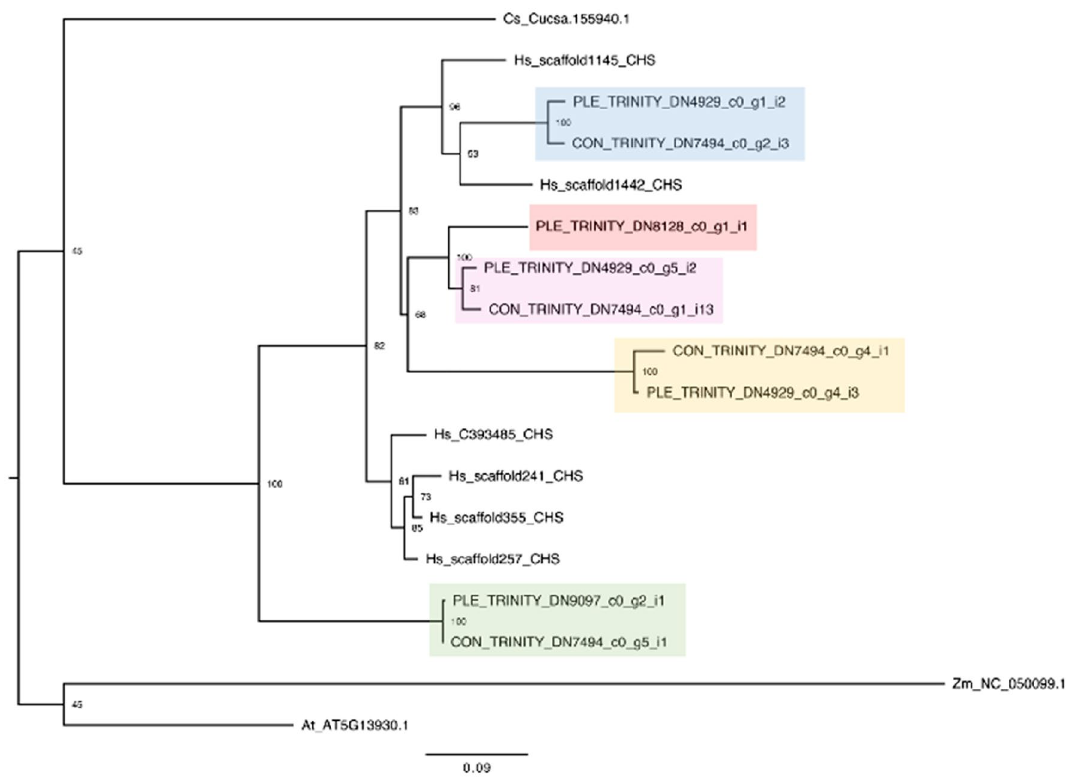
Figure 4. ML tree of CHS sequences from B. conchifolia (CON), B. plebeja (PLE), H. sandwicensis (Hs), C. sativus (Cs), A. thaliana (At) and Z. mays (Zm) . Pairs of orthologs are highlighted as follows: blue: group 1, pink; group 2, yellow: group 3, green: group 4, red: group